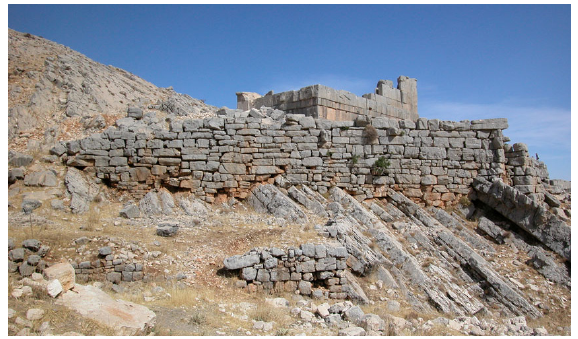
Figure 14. The wall retaining the new platform housing the 2 nd century temple of Hosn-Niha . © J. Yasmine; 2003.